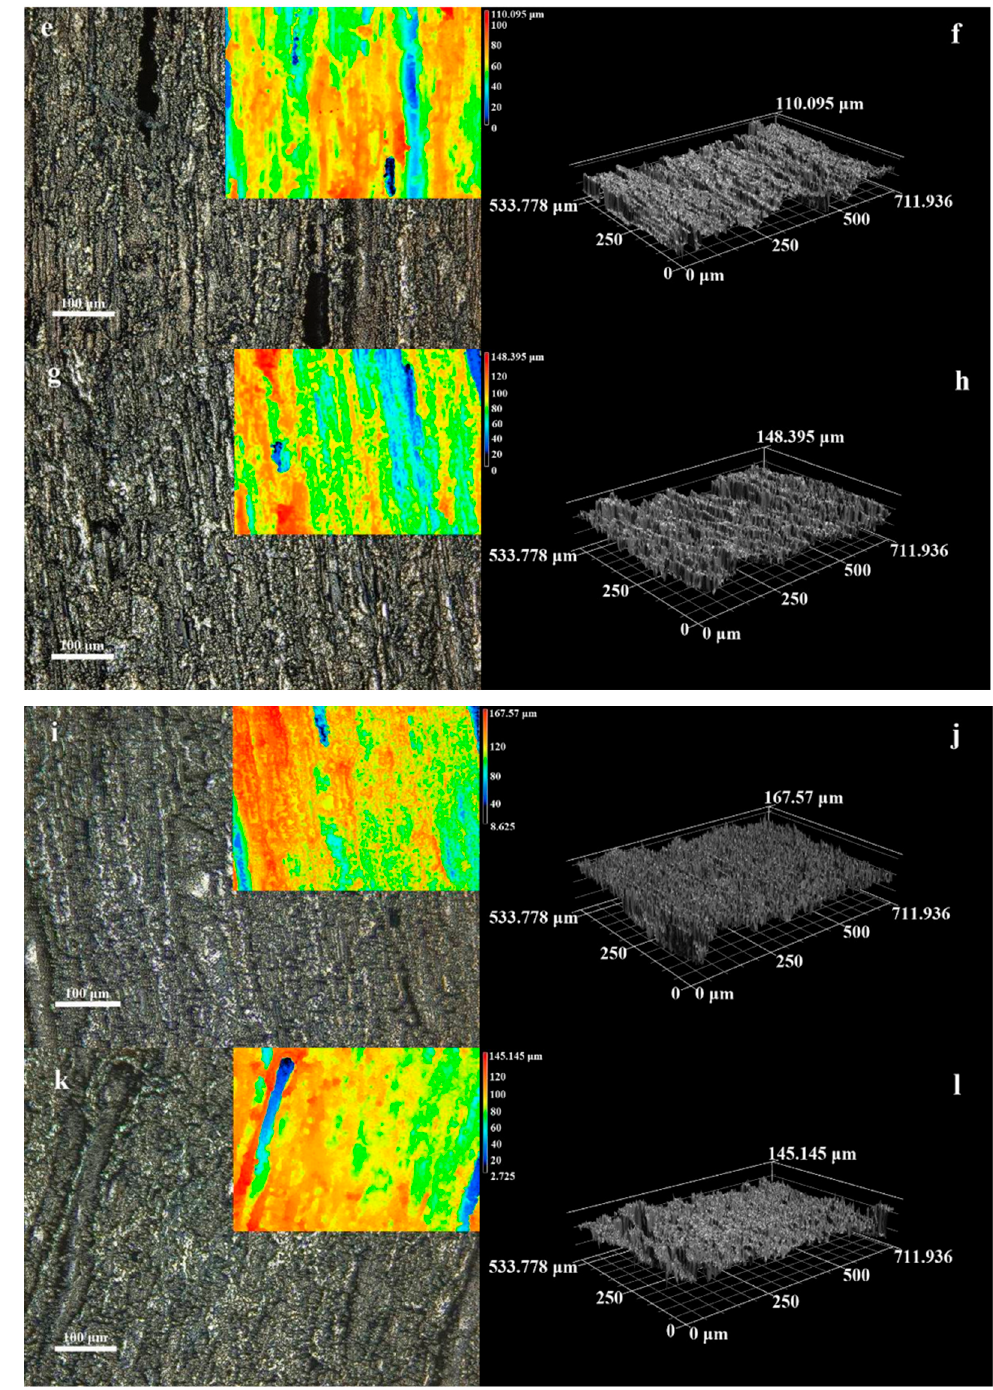
Figure 6. The morphology of the second electroless Ni wood surface by laser copolymerization microscope was 200 × (( a , c , e , g , i , k ) followed by the morphology of the wood surface after electroless Ni for 1, 5, 10, 15, 20, 25 min. The embedded figure is the well depth figure; ( b , d , f , h , j , l ) is 3D figure of electroless time 1, 5, 10, 15, 20, 25 min, respectively).